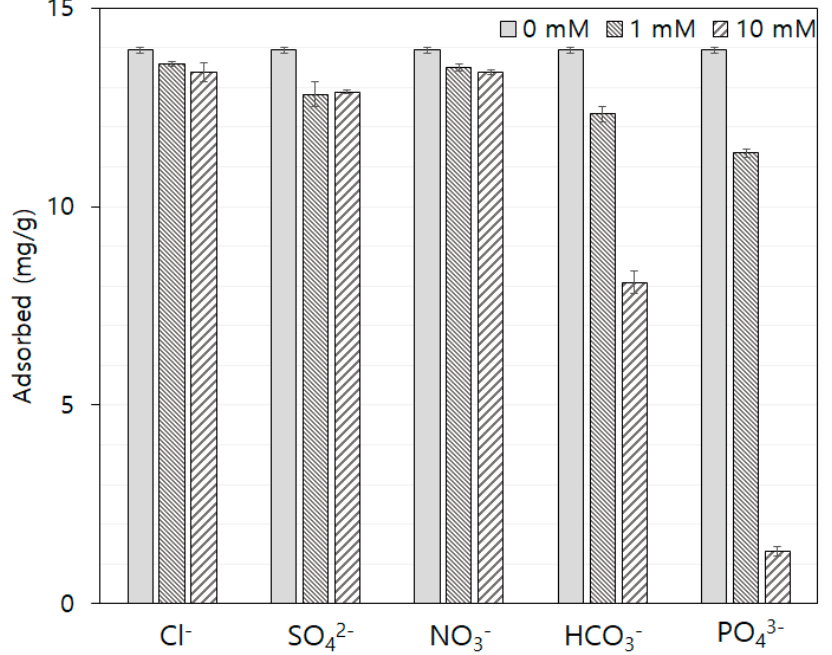
Figure 8. Sb(V) adsorption by Fe-CMB in the presence of 1 and 10 mM chloride (Cl − ), sulfate (SO 42 − ), nitrate (NO 3 − ), bicarbonate (HCO 3 − ), and phosphate (PO 43 − ).